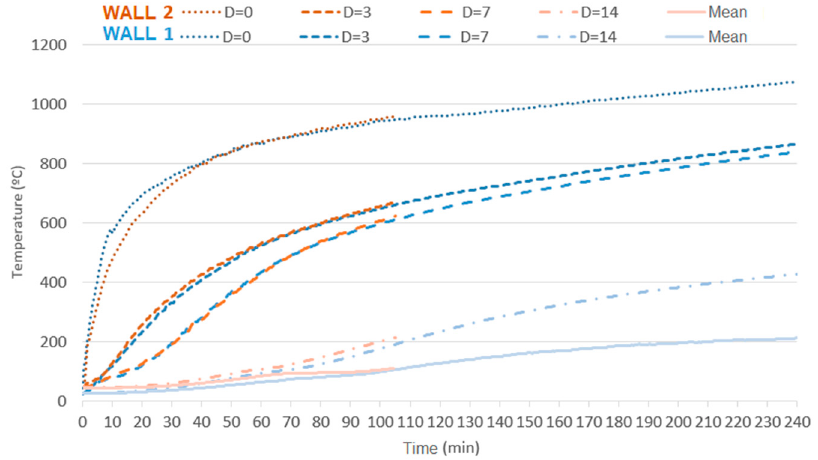
Figure 20. Influence of loading on masonries with no coating on the fire-exposed face.